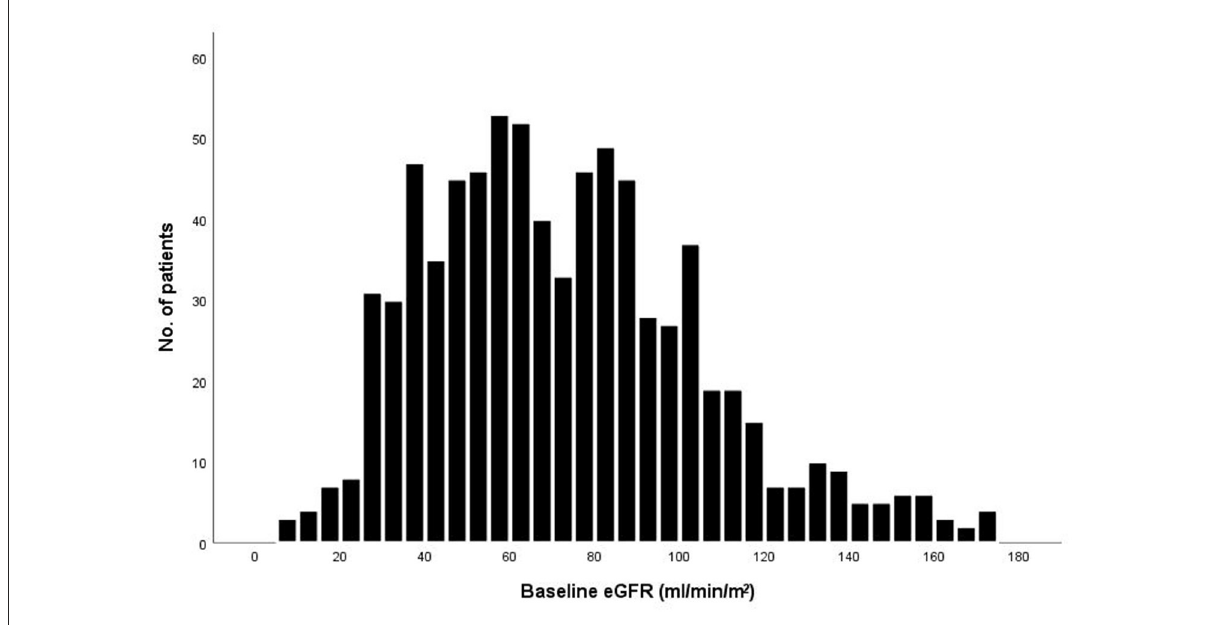
FIGURE1 Distribution of eGFR at baseline among the 789 patients.